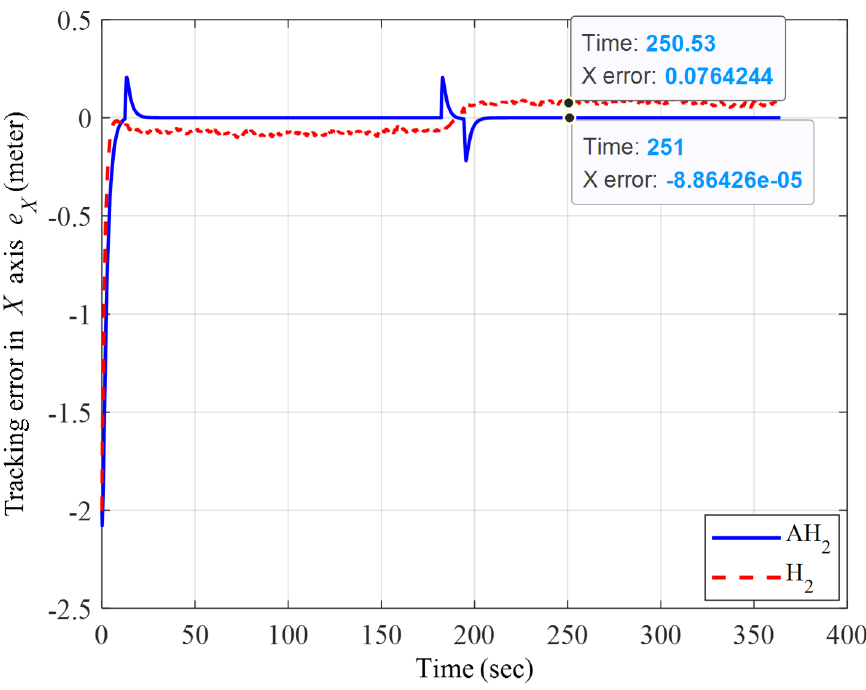
Figure 8. The square trajectory tracking error result of the adaptive H 2 closed-form and H 2 closed- form control approaches for the x -axis from x p = − 7 m, y p = 7 m.